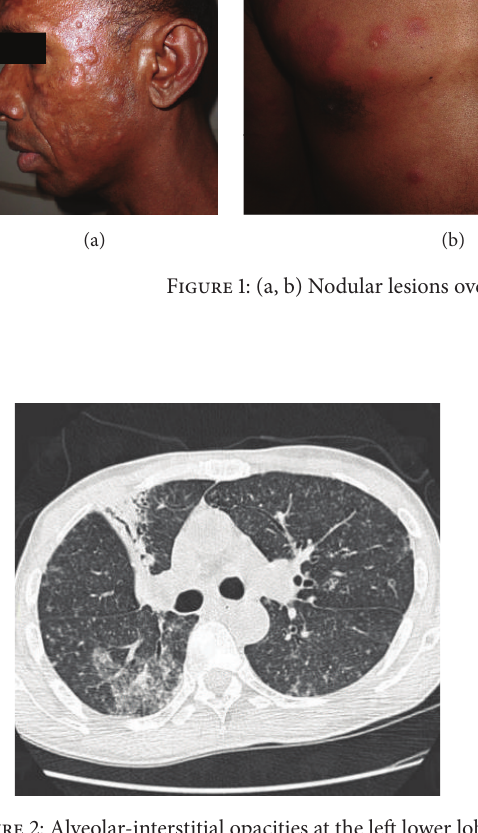
after the onset of this treatment, there were only two nodular lesions on the trunk, fever disappeared, and general status